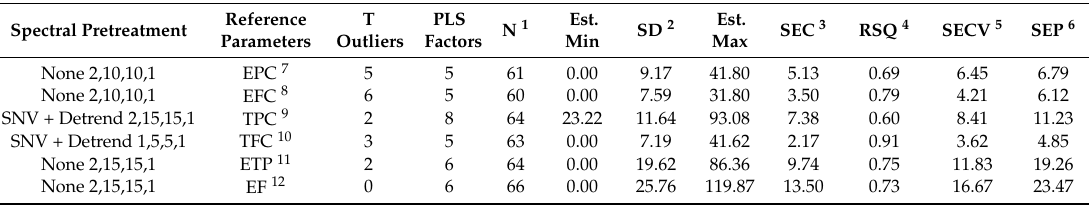
Table 2. Main statistical descriptors for the MPLS models developed in the NIR zone close to 950–1650 nm.